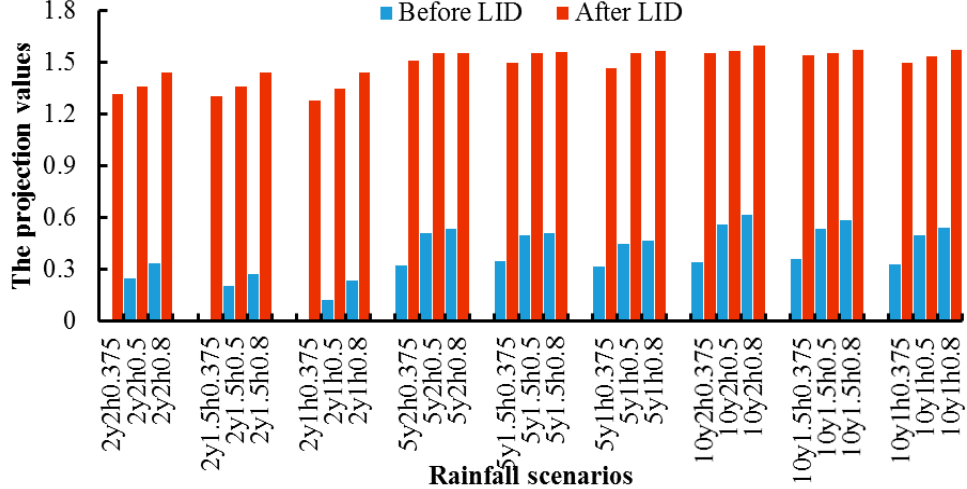
Figure 6. Changes in the projection values of J9 and LID control characteristics under complex scenarios.